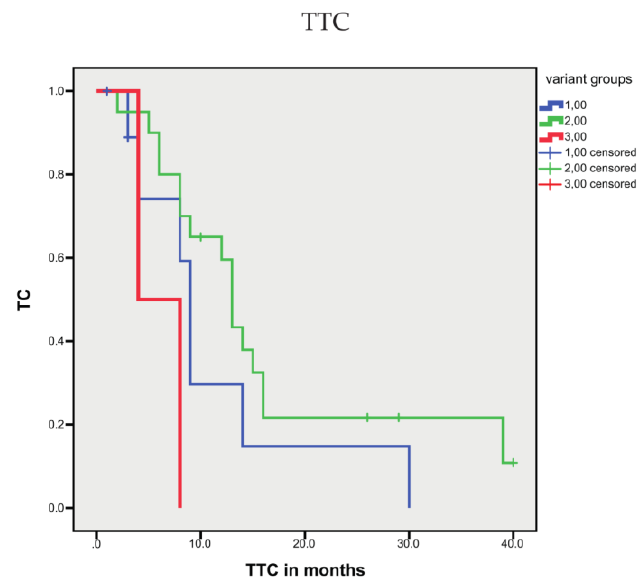
Figure 7. Association of sequence variant groups with TTC. The three sequence variant groups showed a significant association with TTC ( p = 0.017).